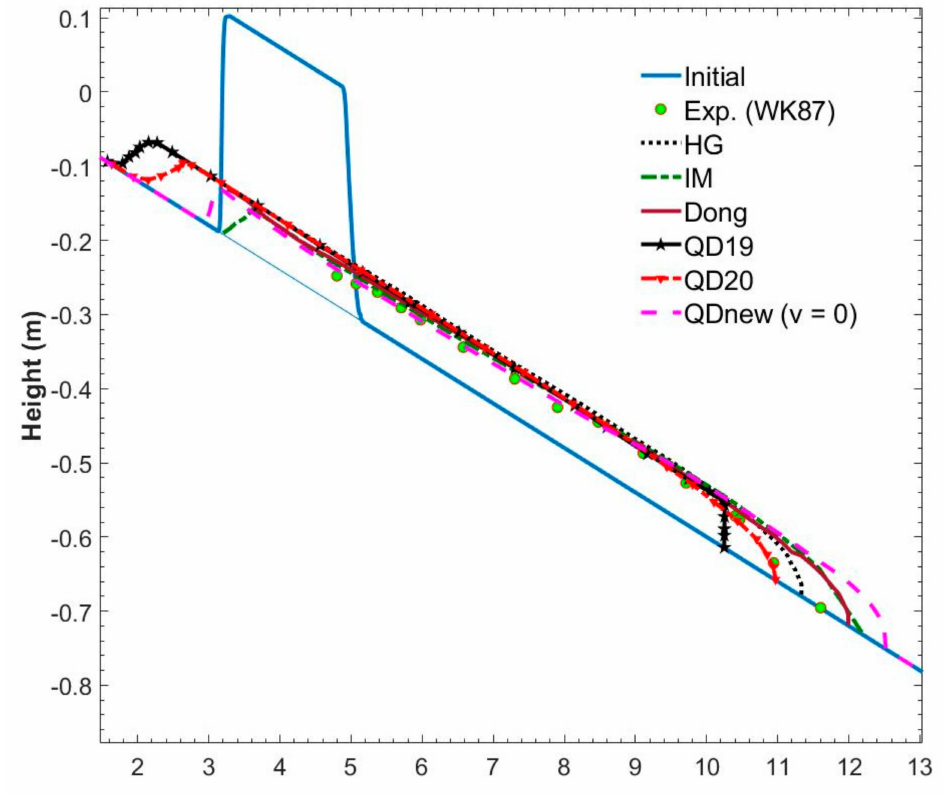
Figure 1. Comparison of debris-flow height between experimental, analytical, and numerical data sets for case WK87 (“Exp.” data from Wright and Krone [34]; “Analytic” data from Huang and Garc í a [8]; IM from Imran et al. [3]; Dong from Dong et al. [46]; “Num. QD19, QD20” data from Qian and Das [7], Qian et al. [1],